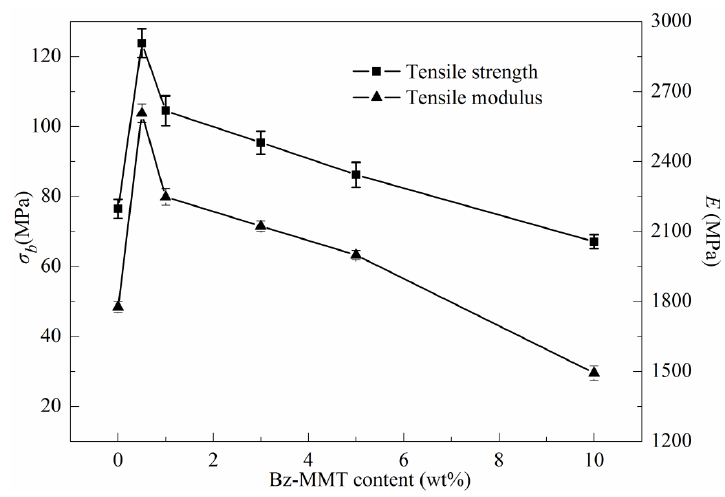
Figure 3. Tensile properties of PPS and PPSBM x composites: (σ b ) tensile strength; ( E ) tensile modulus.